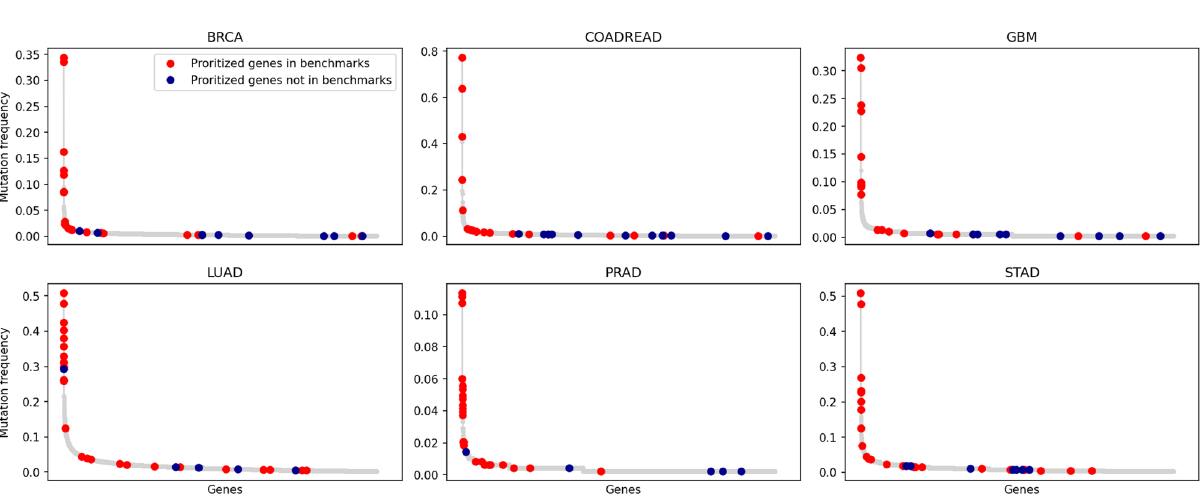
Figure 4. DCG of DiSCaGe and related methods: the relevance (y-axis) of a ranking of a specific number of genes (x-axis), taking into account their position in the ranking and their appearance in the driver benchmarks.